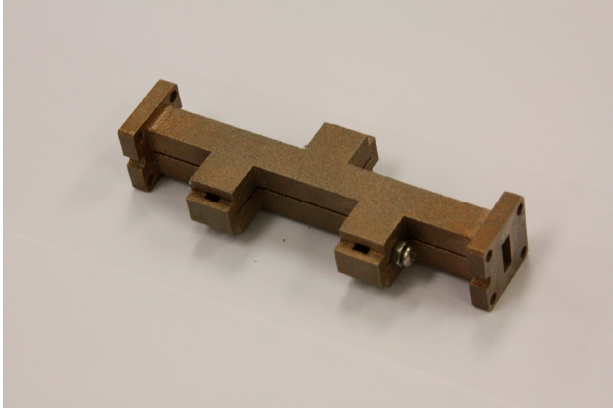
Figure 9. Binder infusion metal 3D printed cavity notch filter.